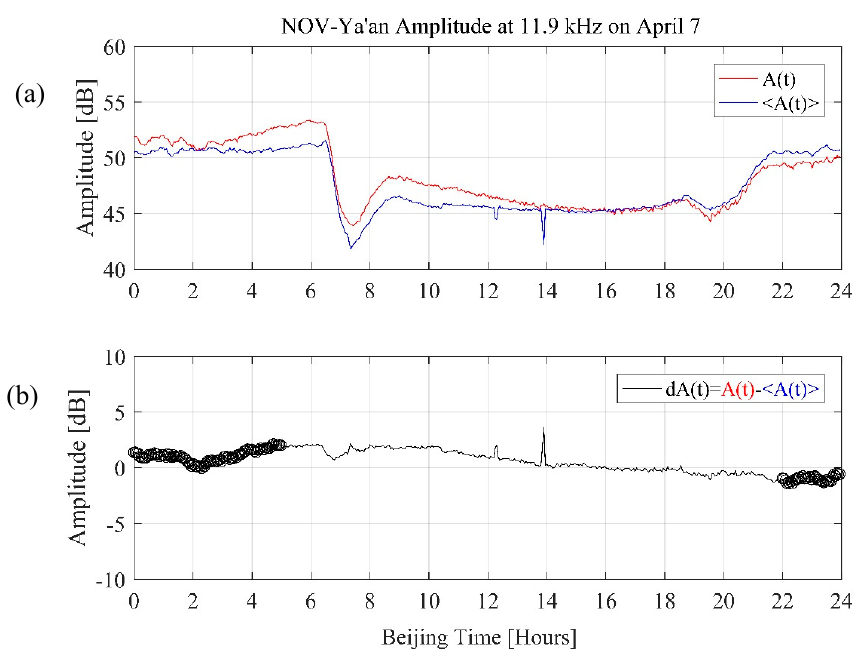
Figure 2. ( a ) The A(t) represents current Ez amplitude between NOV and Ya’an on 7 April, the <A(t)> represents the average Ez amplitude of background (3 days). ( b ) shows the difference of Ez amplitude of A(t) and <A(t)> on 7 April, the black circles mark the selected nighttime data.